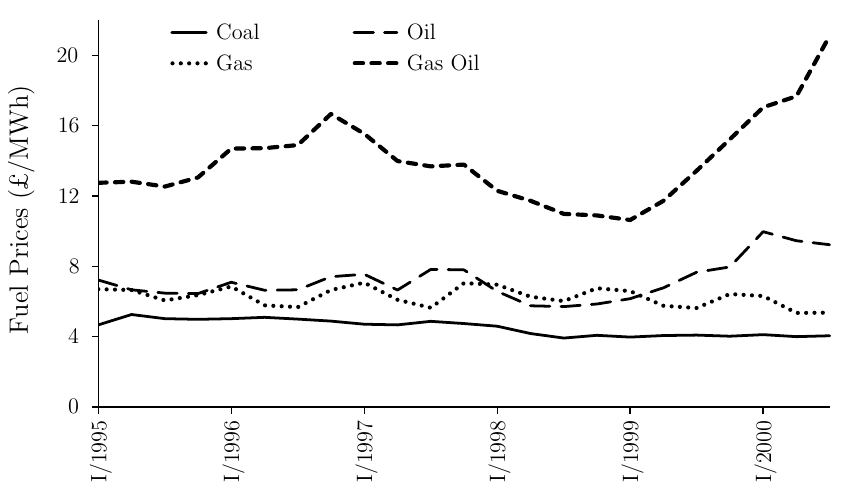
Figure A3. Quarterly fuel prices for major power producers in Great Britain [2,42].